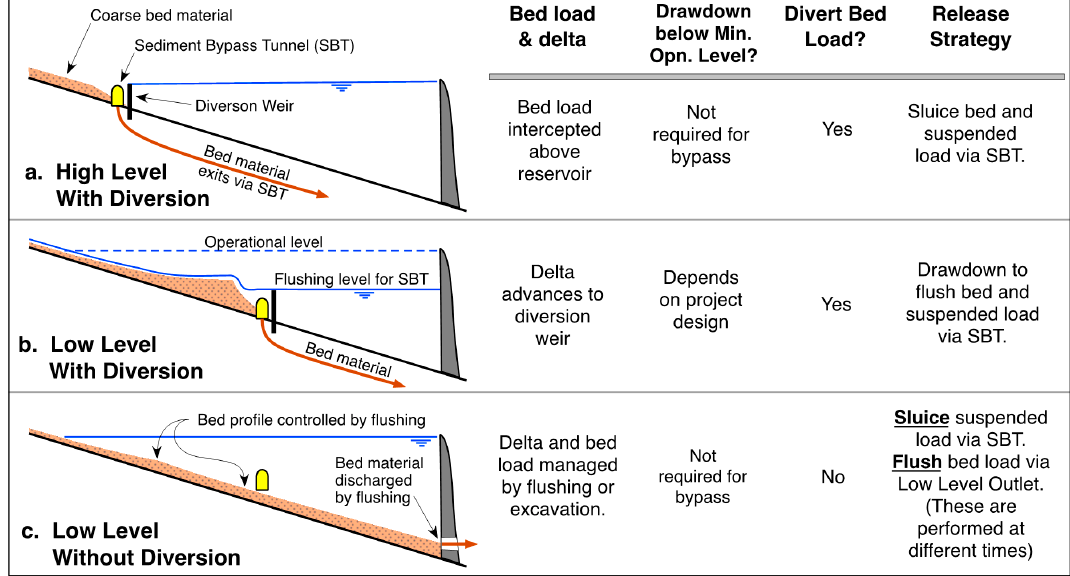
Figure 4. Sediment bypass configurations showing distinctive characteristics of